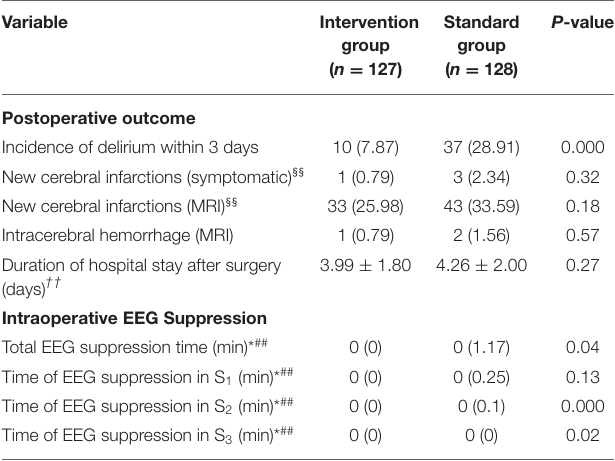
TABLE 3 | Postoperative outcomes and related intraoperative